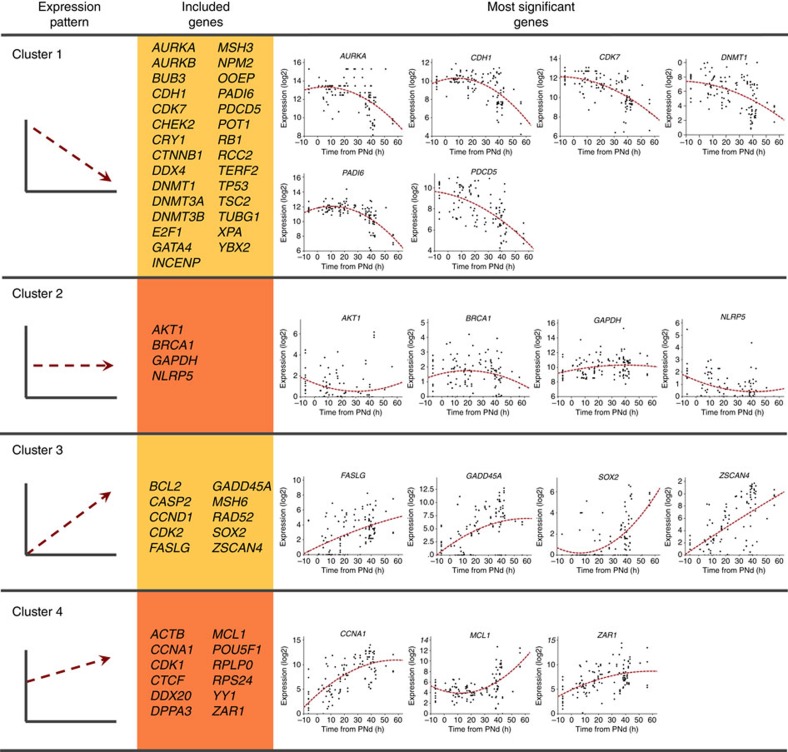
Identification of gene expression clusters during human embryo development.Significant quadratic regressions were classified into four different clusters according to the expression trend versus time. The majority of genes included in Cluster 1 (n=29) were expressed in the zygote stage but decreased in expression by at least twofold between the start and the final time. Cluster 2 (n=4) was composed of genes that showed relatively constant expression as defined by an increase or decrease in expression of less than 1 point. Cluster 3 (n=10) consisted of genes with an expression value lower than 2 at time zero and at least a twofold difference at the final time point. Lastly, Cluster 4 (n=12) comprised those genes with expression higher than 2 at time zero, and twofold or more at the last time point. The most significant regressions from each gene cluster were selected by ANOVA test with P<1 × 10−6 and fold change>10 for Clusters 1, 3, 4 and P<0.05 for Cluster 2. Each expression data point corresponds to the mean value obtained from three technical replicates. A baseline of Ct=28 was used to obtained the showed expression values.